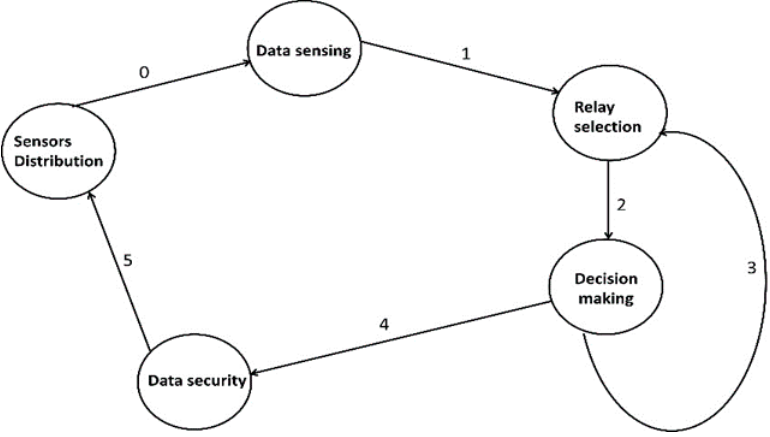
Figure 5. States of the proposed